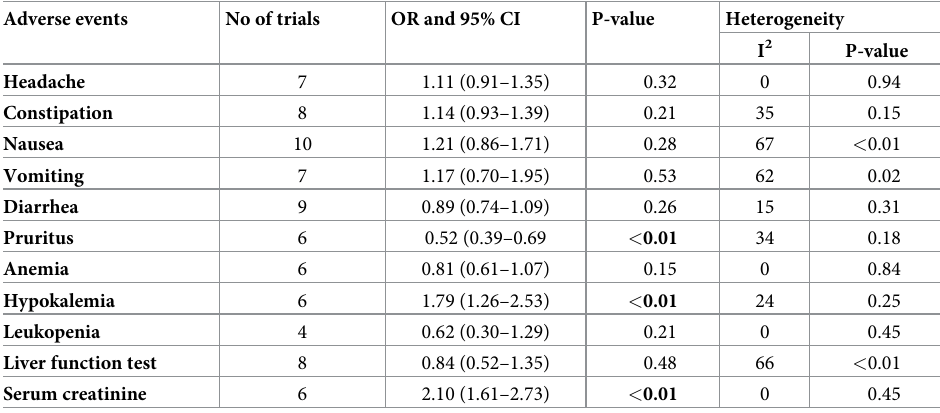
Fig 8. Mortality rate related to novel glycopeptides against vancomycin in the modified intent-to-treat population. https://doi.org/10.1371/journal.pone.0260539.g008 Table 3. Summary of specific adverse events compared between novel glycopeptides and